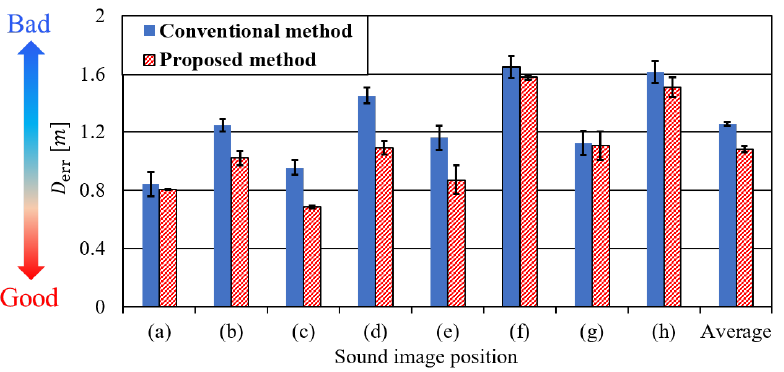
Figure 12. Error between the position of the estimated position and that of the target sound im- age D err